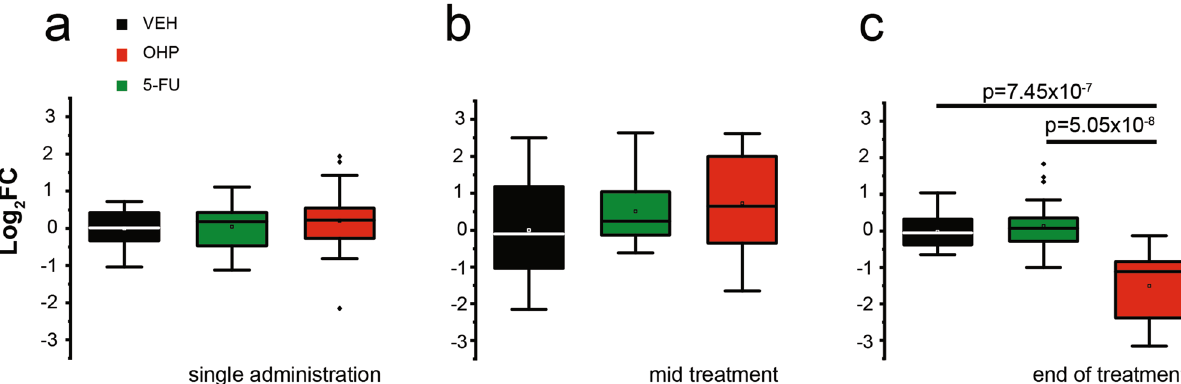
Figure 6. OHP affects the transcription of NHE1 in the DRG in vivo. Mean (square), the median (line across the box), and interquartile range (box) of treated vs. VEH log 2 FC of gene expression, as measured